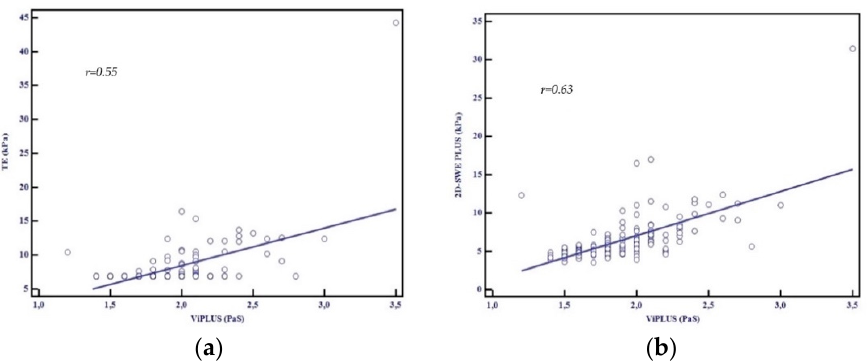
Figure 6. ( a ) Relationship between the mean values assessed by TE and Vi.PLUS, Pearson`s corre- lation coefficient, r = 0.55; ( b ) Relationship between the mean values assessed by 2D-SWE.PLUS and Vi.PLUS, Pearson`s correlation coefficient, r = 0.63.